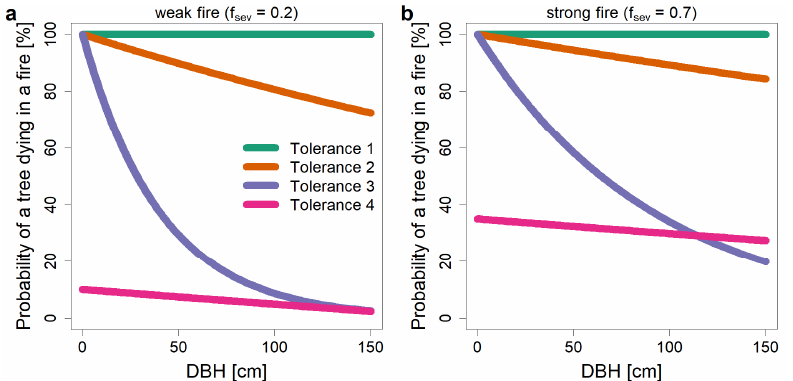
Figure 7. Probability of death of a tree in a fire event, after [43]. This probability depends on the fire tolerance of the tree species, the stem diameter in breast height (DBH), and the severity of the fire (f sev ). ( a ) The probability of death in a weak fire (f sev = 0.2). ( b ) The probability of death in a stronger fire (f sev = 0.7).